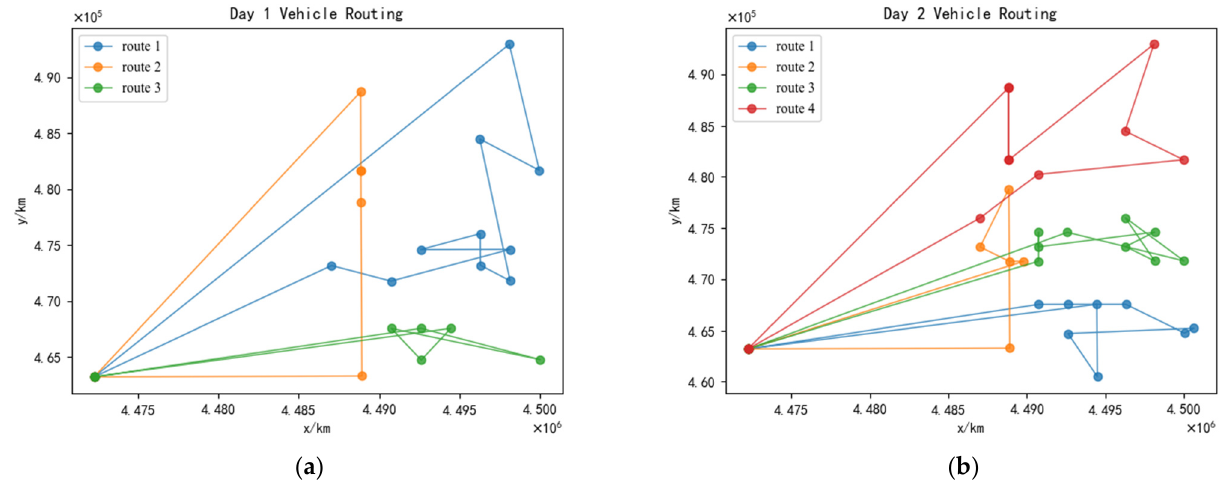
Figure 9. The optimal recycling schemes under the cyclical recycling strategy. ( a ) Medical waste recycling vehicle route of the first day. ( b ) Medical waste recycling vehicle route of the second day.